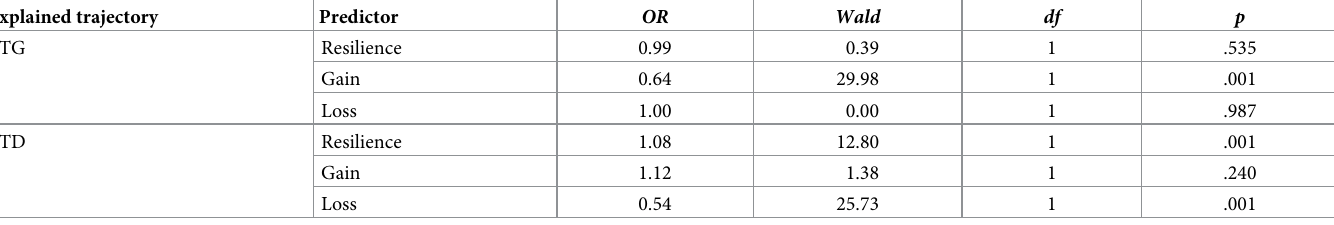
Table 5. Analysis of relationships between the levels of resilience, gain and loss in the first measurement and trajectories of PTG and PTD among study participants. Explained trajectory